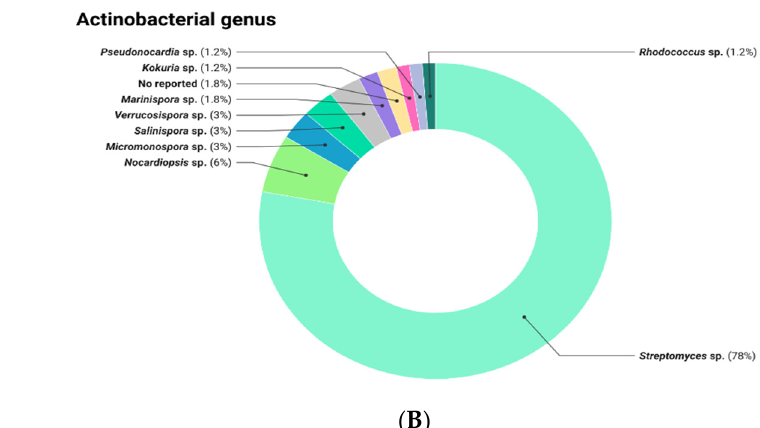
Figure 3. ( A ). Number of works related to marine actinobacteria per year organized by four-year period. ( B ). Actinobacterial genus reported in the studies of marine